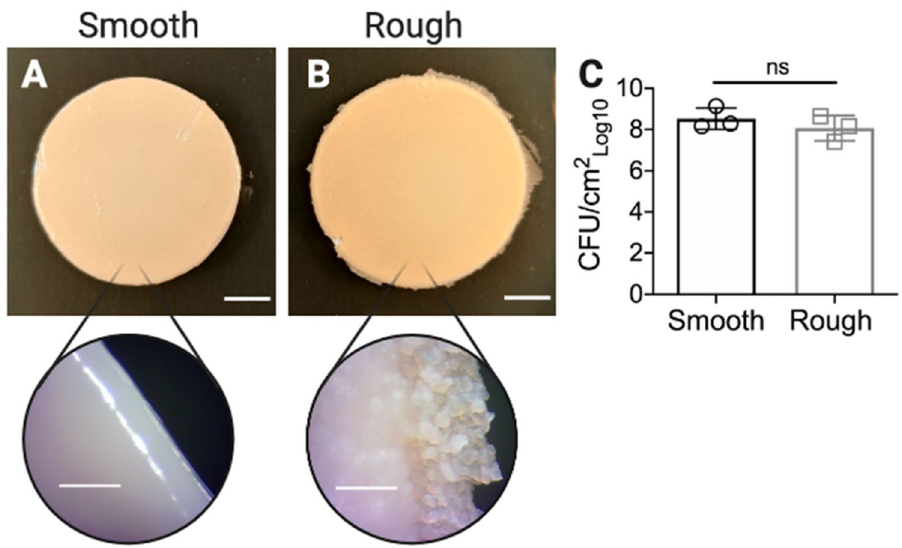
Figure 1. Morphology of Ma Sm and Ma Rg colony-biofilms. (A) Ma Sm and (B) Ma Rg were grown on nitrocellulose membranes for 4 days, transferring the membranes onto fresh media after 48 h. Colony-biofilms were then imaged to visualize the macroscopic morphology. Scale bar indicates 5 mm, and 0.5 mm for the zoomed insets. (C) To assess the biomass and if each variant was stable during biofilm formation, 4 day M . abscessus biofilms were enumerated for CFUs. Evidence of phenotypic changes of the colony morphologies for either was not observed at 37ºC over 4 days. Statistical analysis was performed using a Student’s t-test; ns indicated not significant. N =